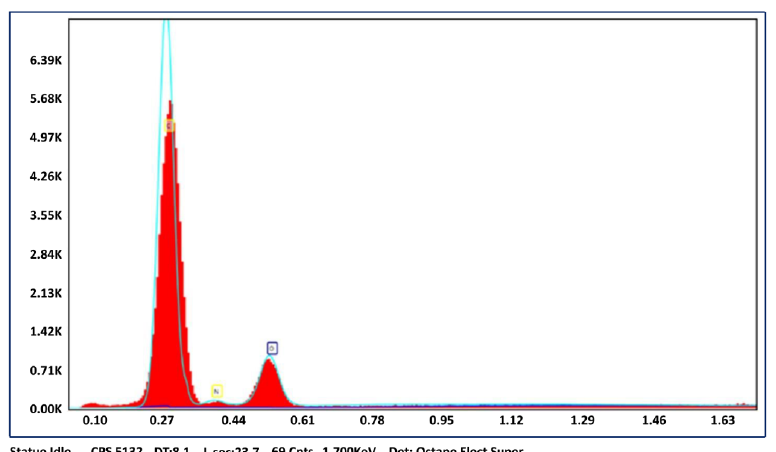
Figure 4. EDS spectra of HEMPA nanopolymer synthesized using the mini-emulsion polymeriza- tion technique.